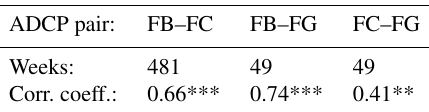
Table 3. Correlations between pairs of weekly averaged along- channel (towards 304 ◦ ) velocities for the three ADCP sites in the Faroe Bank Channel at their reference depths, which are 398m for FC, 343m for FB, and 122m for FG. “Weeks” indicates the number of values for each